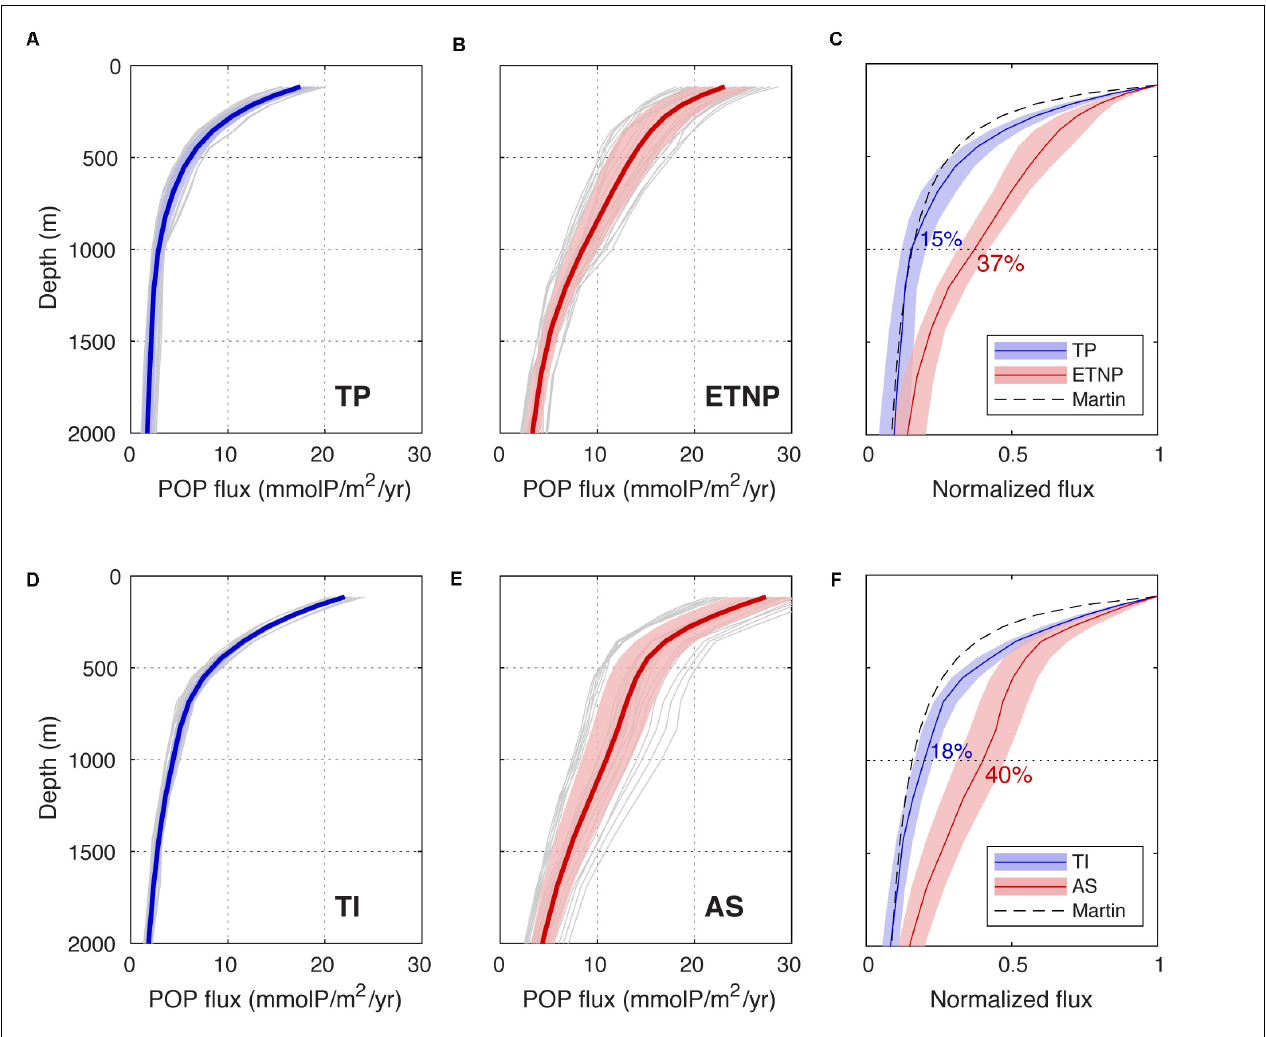
FIGURE 2 | Reconstructed particle flux profiles. (A,B,D,E) , Flux profiles of particulate organic phosphorus (POP) averaged across the TP, ETNP, TI and AS regions, respectively, reconstructed by diagnosing PO 4 accumulation in an ocean circulation model. Gray lines show the individual profiles derived from an ensemble of different ocean circulation models. Central red and blue lines show the ensemble-means, and shaded envelopes delineate ± 1 σ from the mean. (C) , Ensemble-mean flux profiles and uncertainty envelopes from the TP and ETNP regions are normalized to the flux at the base of the euphotic zone, facilitating comparison between profile shapes in the oxygenated tropics and the OMZ. The fraction of the flux remaining at 1000 m is labeled for each region, and the canonical Martin curve (dashed black line) is shown for reference. (F) Same as (C) but for TI and AS